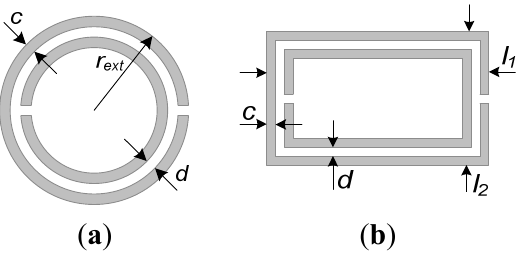
Figure 1. Typical topology and relevant dimensions of ( a ) a circular and ( b ) a rectangular